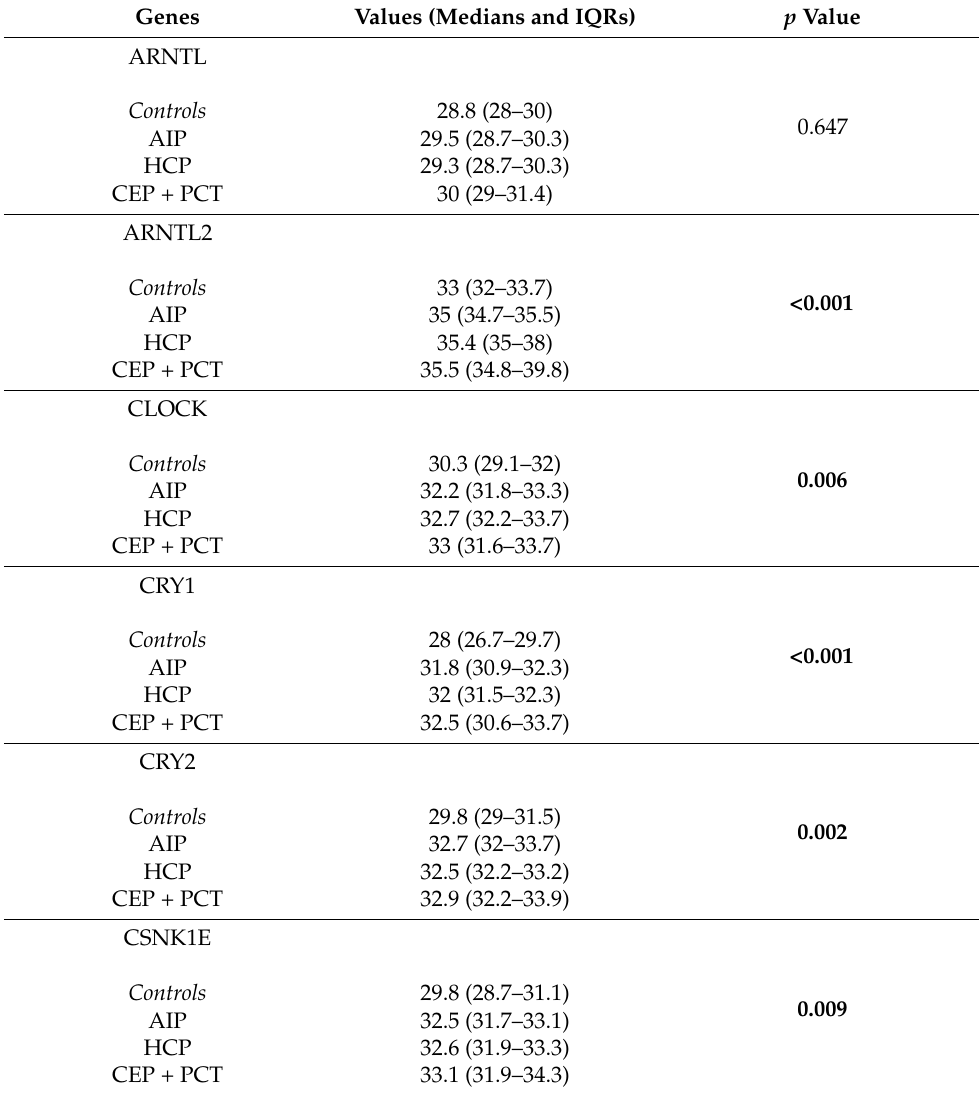
Table 3. Circadian genes expression in controls and patients affected by porphyrias and differences between the groups. Genes Values (Medians and IQRs) p Value